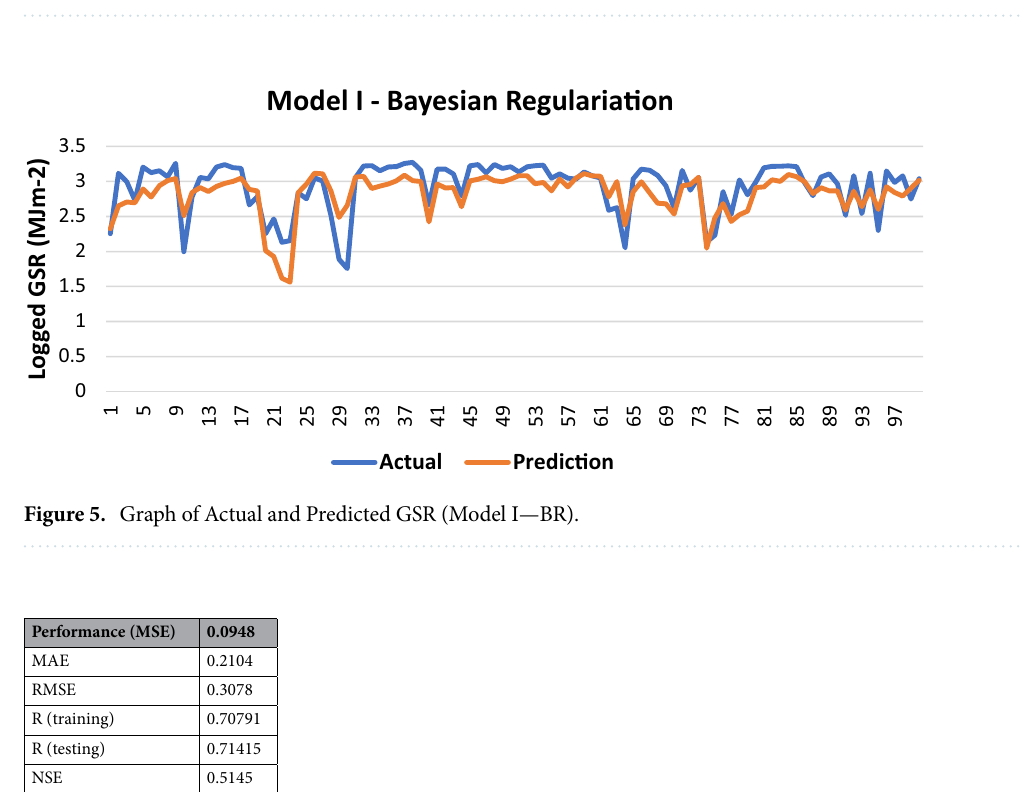
Table 4. Evaluation using BR backpropagation.